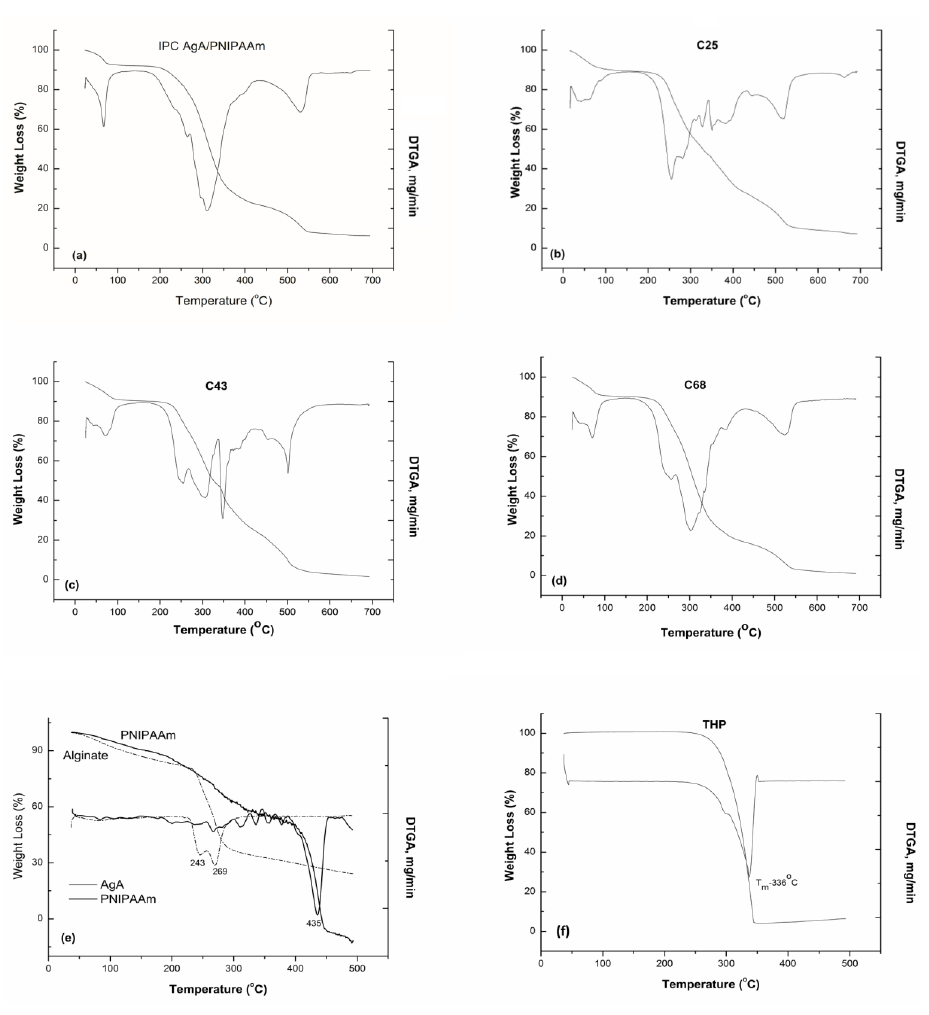
Figure 4. TG and derivative (DTGA) curves of IPC 72/28 ( a ), grafted copolymers (C27— b , C43— c , C68— d ), polymeric components, alginate and PNIPAAm ( e ), and pure theophylline ( f ).